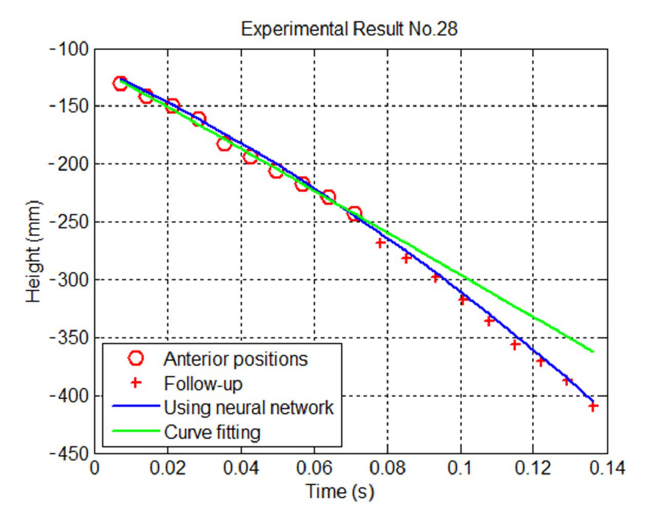
Figure 13. Trajectory based on ten positions (Blue: ANN; green: quadratic polynomial resulting from curve